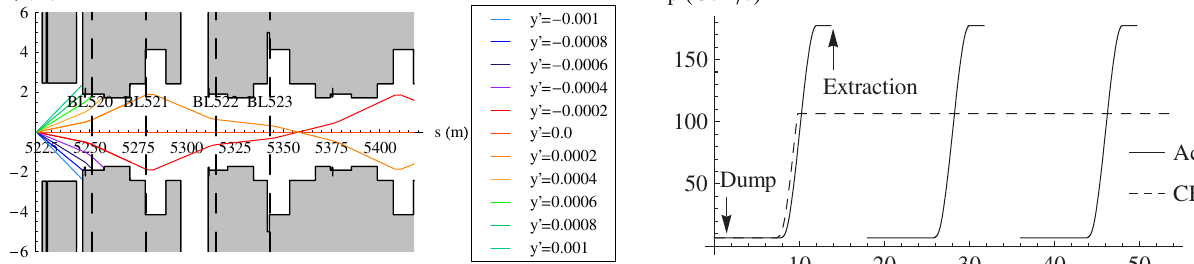
FIG. 8. The 208 Pb 82 þ momentum per nucleon during three cycles of the SPS in the case of acceleration and a circulating beam at constant energy (CBCE). In the acceleration cycle, the dumping of the beam during the collimation measurements is indicated, as well as the extraction momentum.